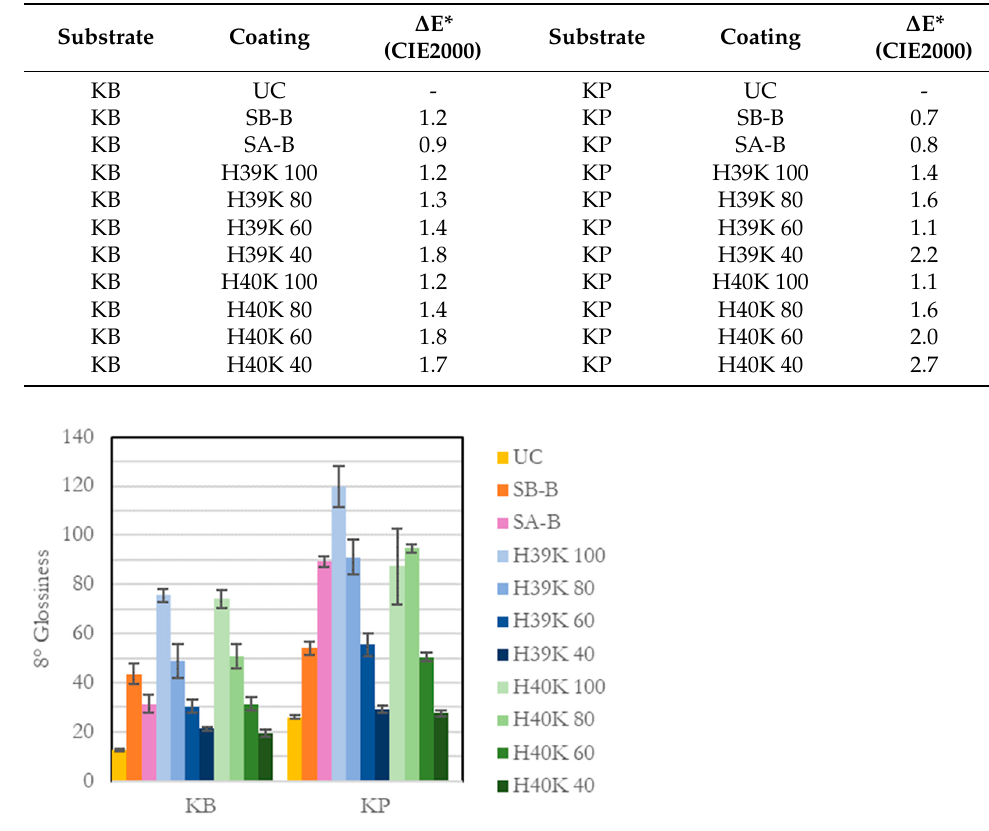
Figure 9. 8 ◦ glossiness for each substrate and coating involved in this Figure 9. 8° glossiness for each substrate and coating involved in this study.